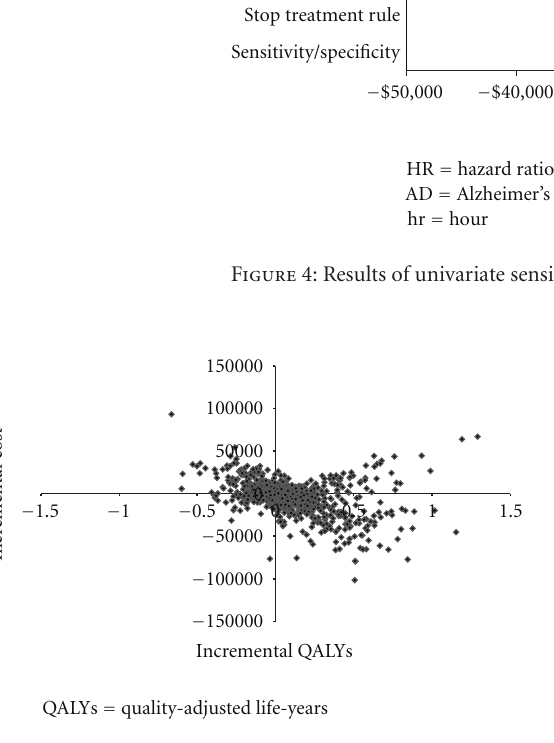
Figure 5: Incremental cost e ff ectiveness plane for predementia cohort.